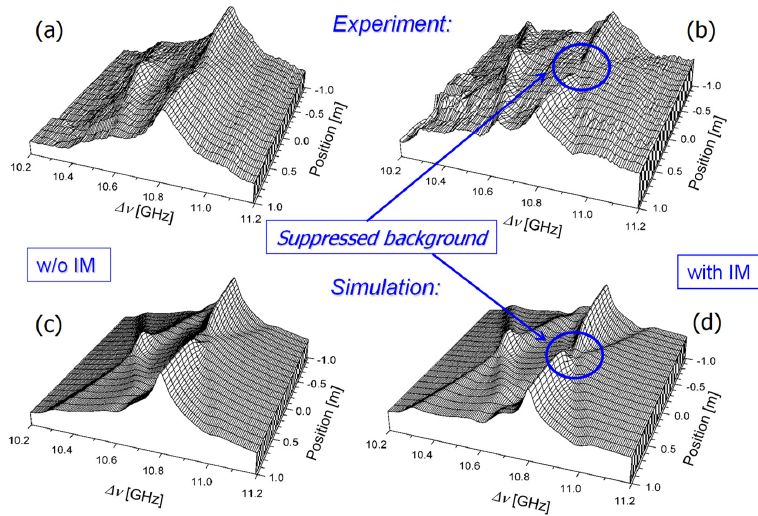
Figure 25. BGS distribution along the fiber obtained in experiments ( a , b ) and simulations ( c , d ), respectively [51]. ( a , c ) are for the case without the IM modulation, and ( b , d ) are for the case with the appropriate IM modulation.